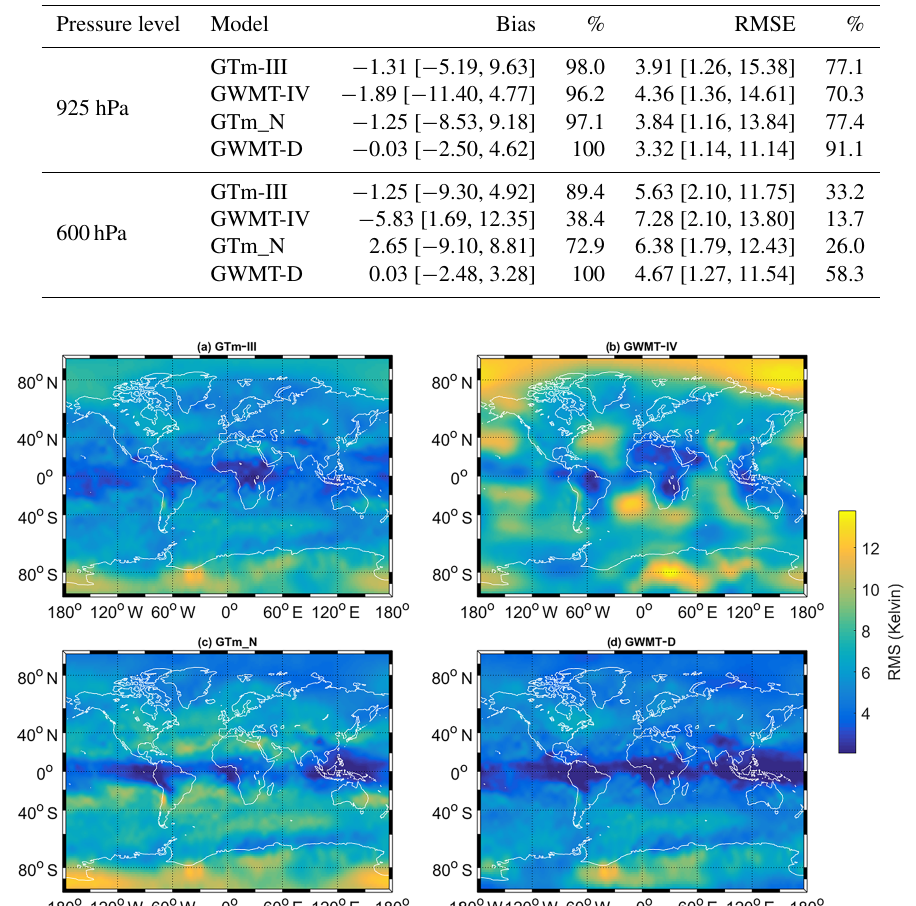
Figure 6. The global RMSE distribution of the differences between the T m derived from each model and the NCEP2 data on pressure level of 600hPa in